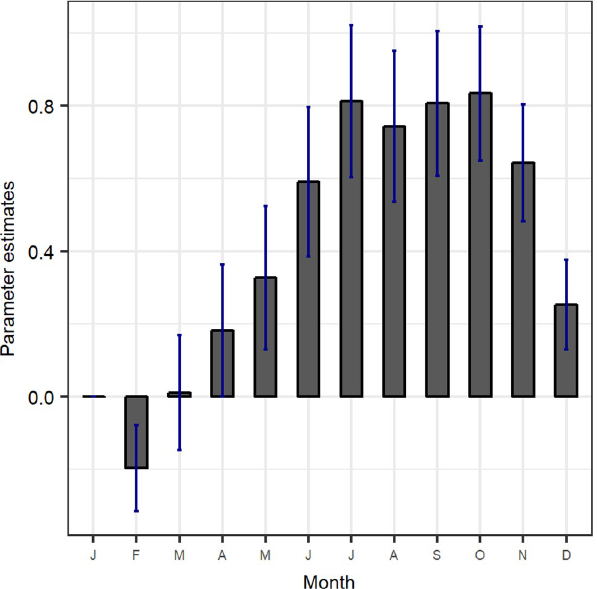
Fig 6. Posterior distributions of the dummy variables used in the model to account for seasonal